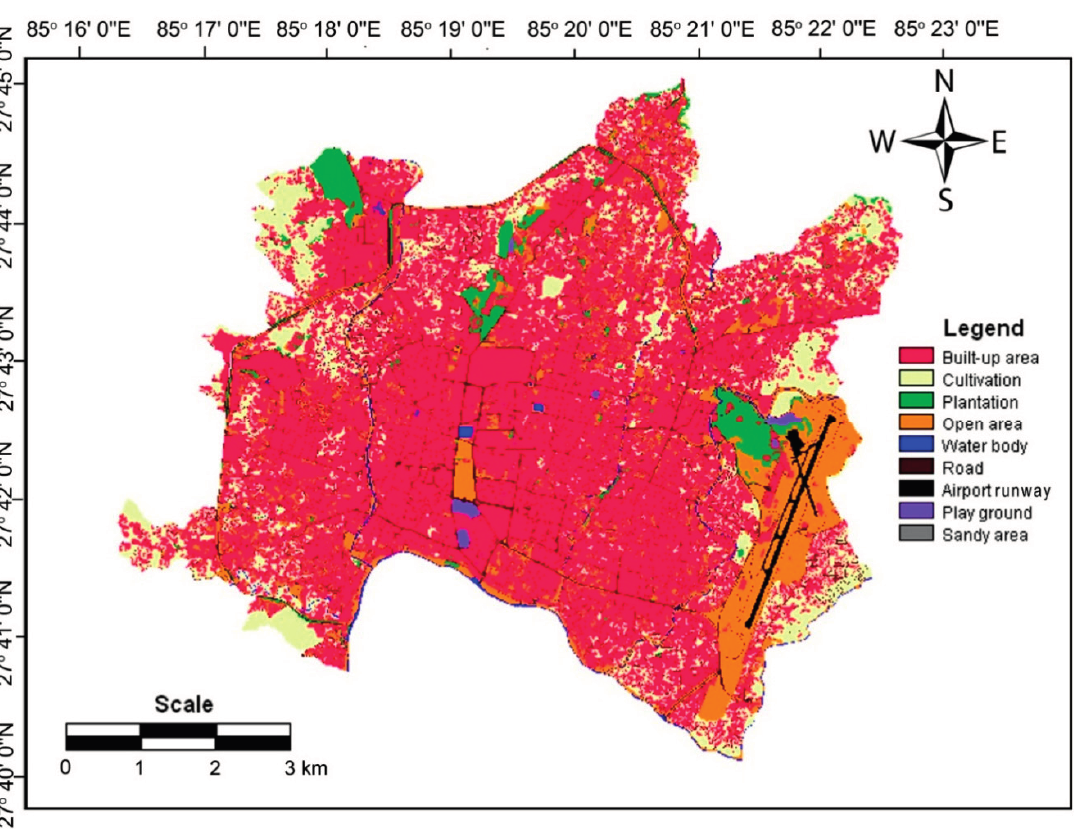
Figure 4. Land use map of Kathmandu Metropolitan